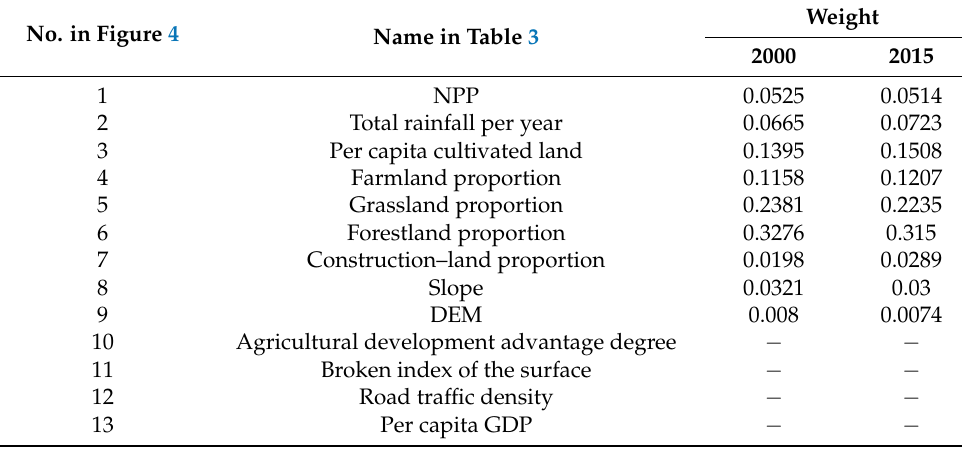
Figure 4. The SD results of each index of 43,046 villages and towns in China. Table 4. Weigh of each index calculated with EWM in 2000 and 2015. Table 4. Weigh of each index calculated with EWM in 2000 and